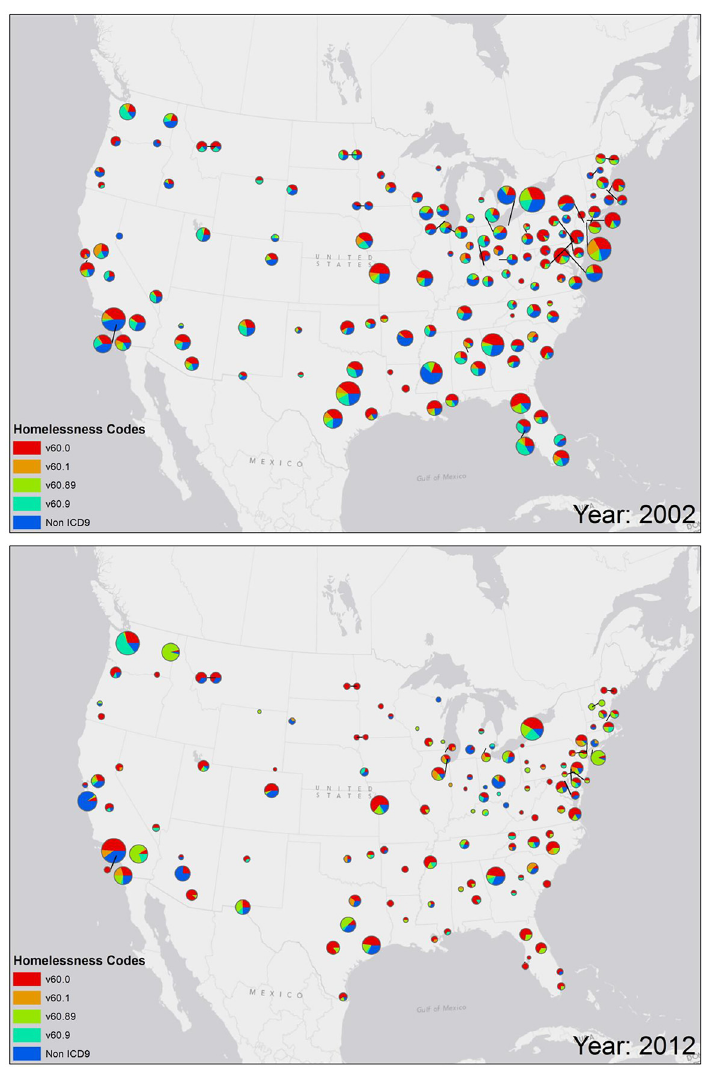
Fig 1. Map of usage of various administrative indicators for the recognition of homelessness in VA medical facilities across the country (V60.0, V60.1, V60.89. V60.9 and non-ICD codes: clinic stop codes and inpatient treatment codes as described in the text). The pie charts are derived from a normalized ratio: the frequency of the specific code given as a first indicator of homelessness (numerator) as a proportion of the total number of Veterans identified as homeless in the area (denominator). Two representative years are shown.